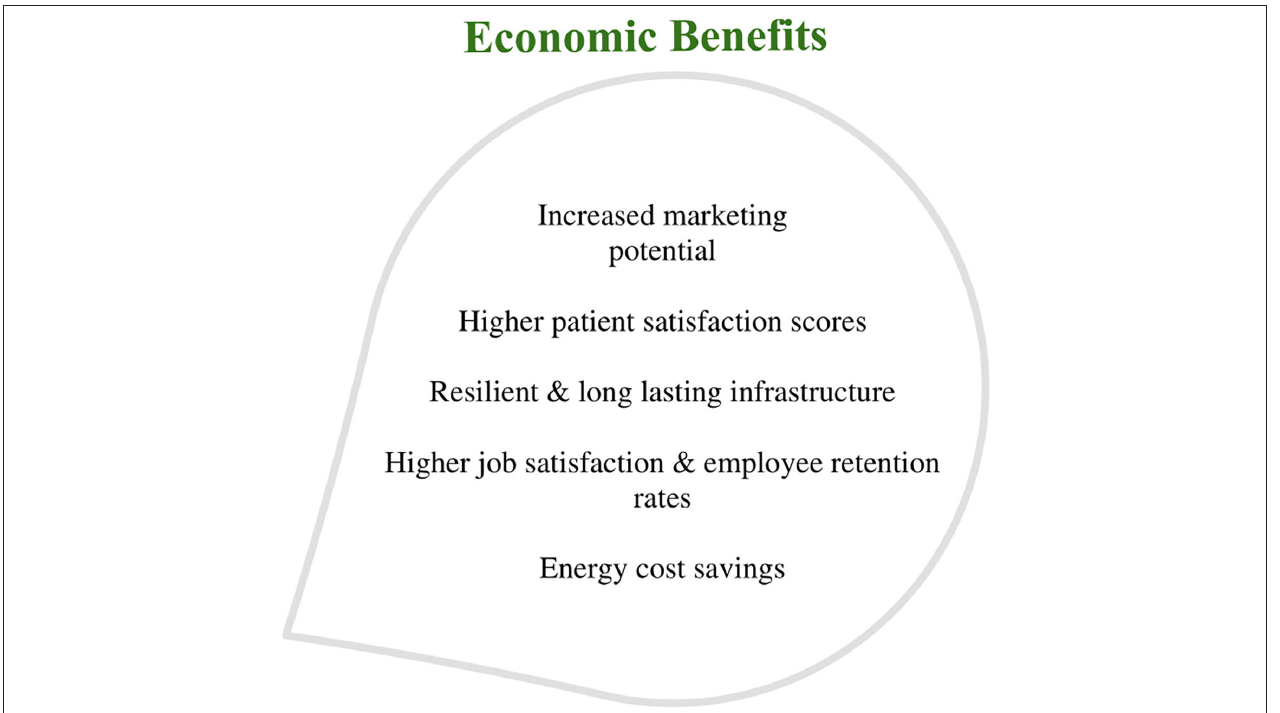
FIGURE 6 | Summary of economic benefits for green roofs on